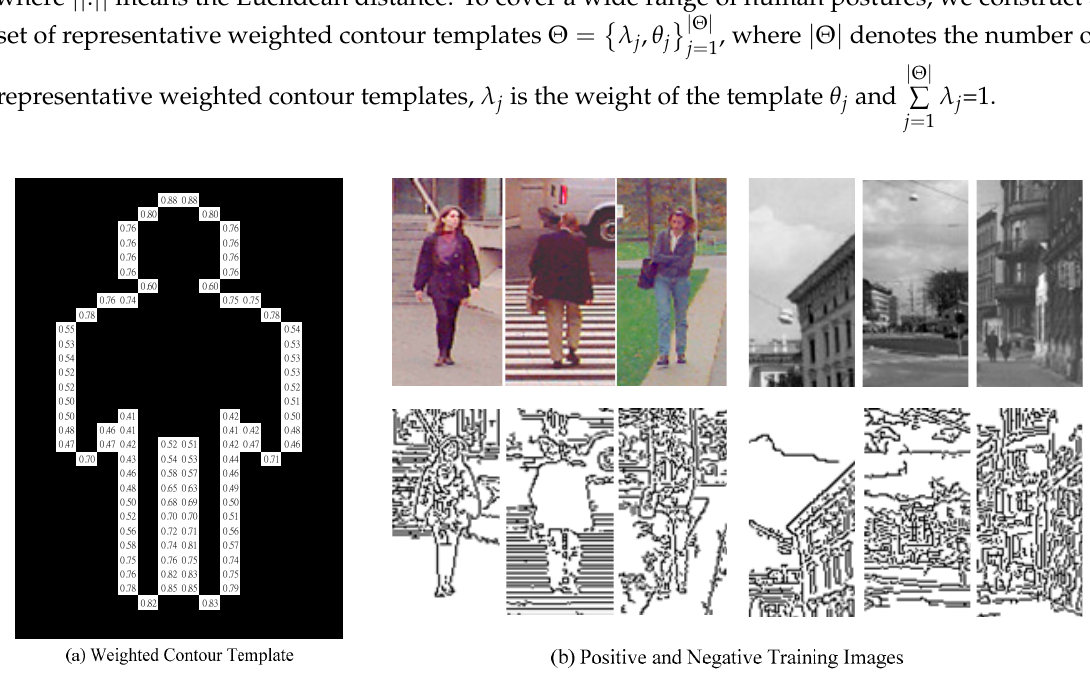
Figure 1. ( a ) Weighted contour template is shown in a schematic form; ( b ) some examples of positive and negative training samples are shown.